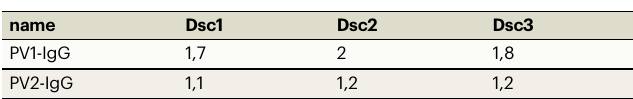
Table 2 | Dsc autoantibody levels of